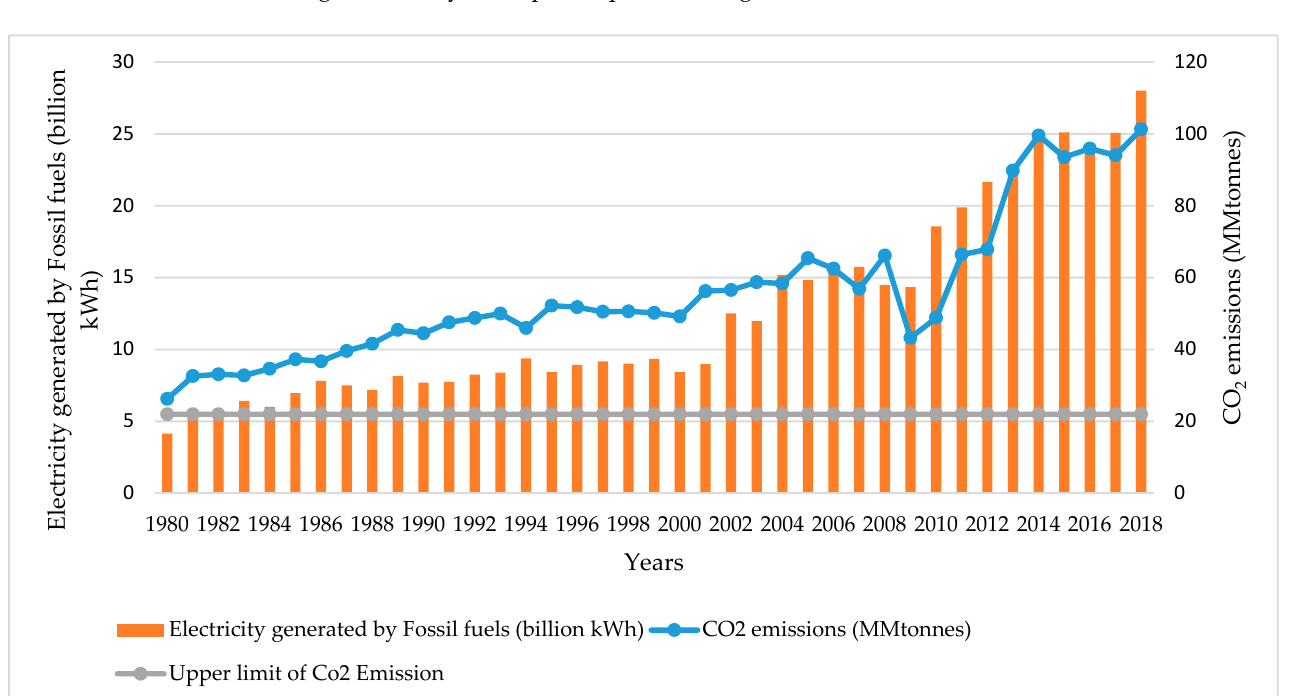
Figure 3. Showing the trend of increasing CO 2 emissions concurrent with the increasing electricity generated by fossil fuels in Nigeria from 1980 to 2018 [39].